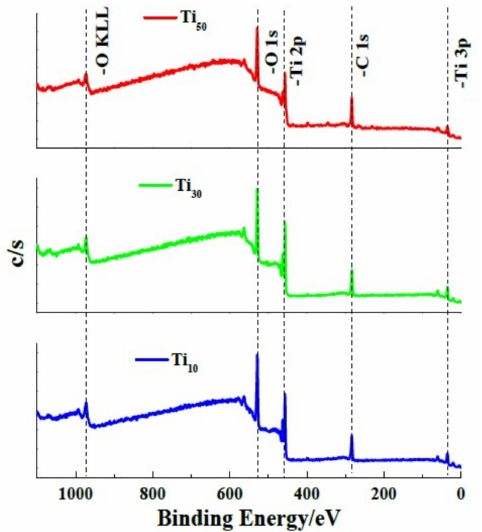
Figure 4. XPS survey spectra of the anodic oxide films formed on different potentials.